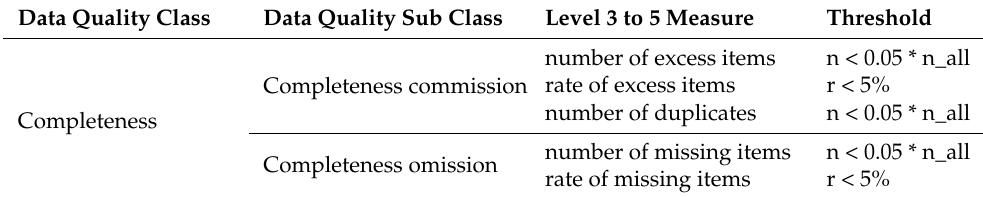
Table 7. Data quality measures and threshold values for the completeness class. Completeness infor- mation is supposed to be mandatory from level 3 to level 5. The thresholds assume a 5% rate of excess or missing items; n_all defines the number of all features; * stands for the multiplication